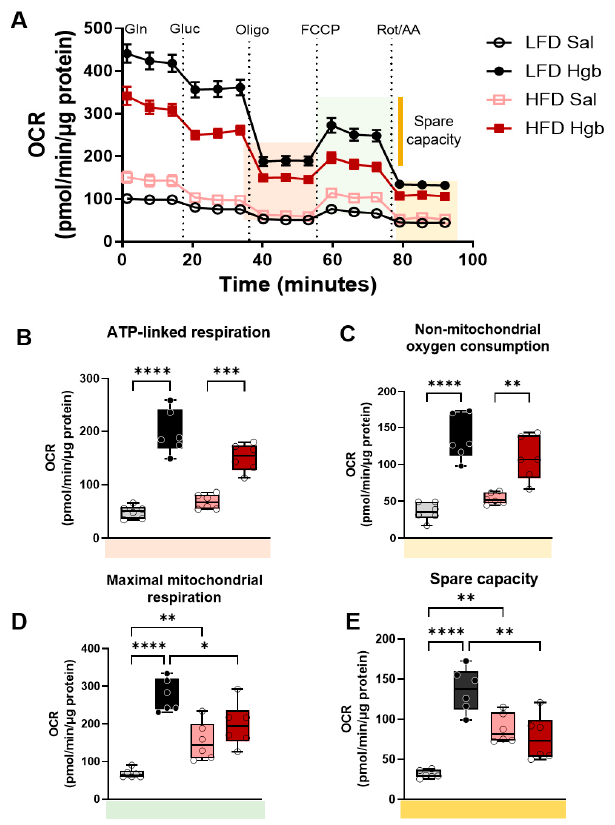
Figure 4. Bioenergetic shifts in response to iron in obese adipose tissue macrophages . Mice were fed a low-fat (LFD) or high-fat (HFD) diet for 20 weeks. At week 19–20 of dietary challenge, mice were injected with either saline (Sal) or hemoglobin (Hgb). Adipose tissue macrophages (ATMs) were isolated via F4/80+ magnetic beads. Mitochondrial respiratory rates were calculated from extracellular flux analysis rates, as described in the Methods section. ( A ) Oxygen consumption rate (OCR) was measured using a modified mitochondrial stress test. ( B ) ATP-linked respiration. ( C ) Non-mitochondrial oxygen consumption. ( D ) Maximal mitochondrial respiration. € Spare capacity. Statistics were performed using two-way ANOVA with Tukey’s multiple comparison post-hoc tests. * p < 0.05, ** p < 0.01, *** p < 0.001, **** p < 0.0001.